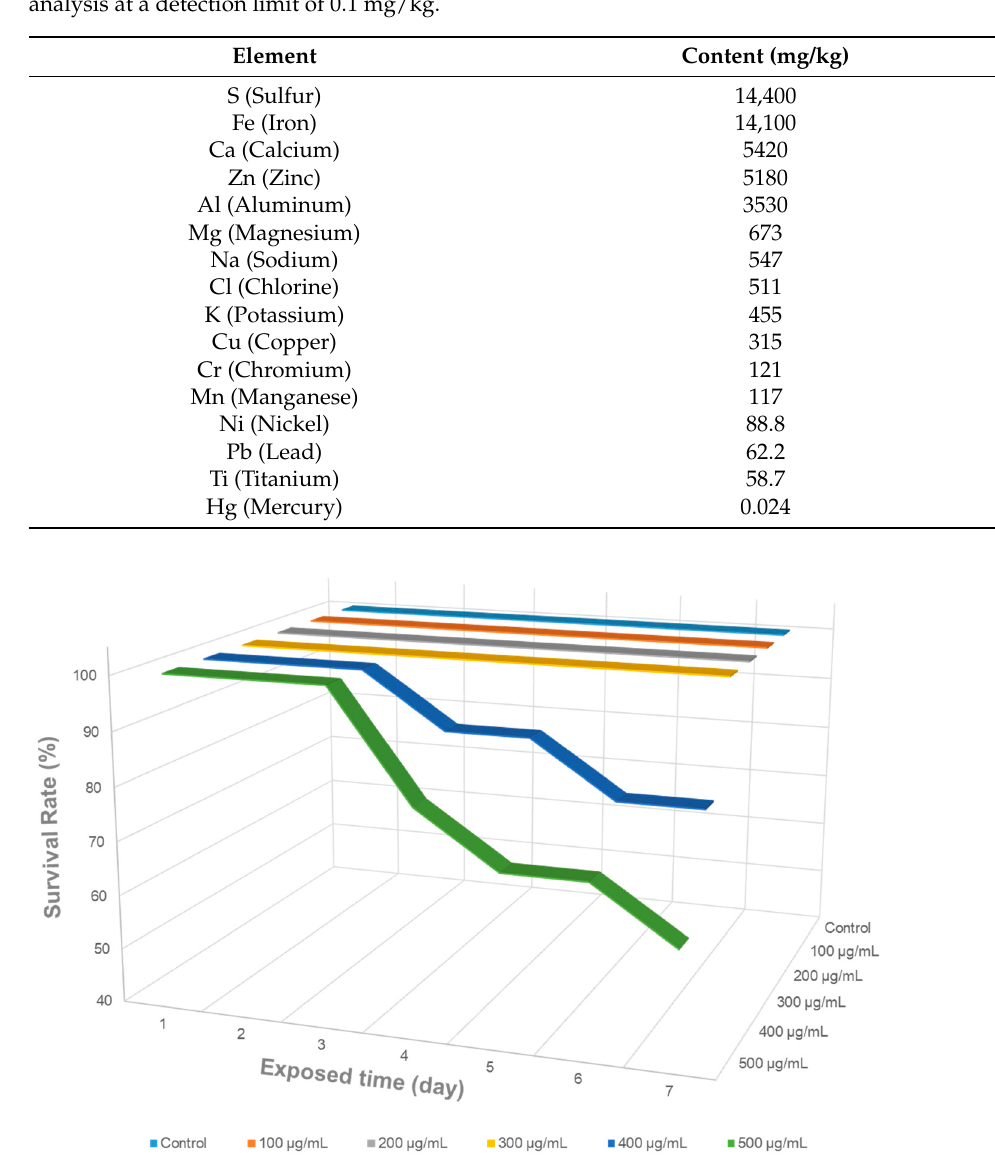
Figure 2. Survival rate (%) of control and zebrafish exposed to different concentrations of KDP20 (100, 200, 300, 400, and 500 µg/mL) for 1 to 7 days. The survival rates were recorded and observed daily ( n = 10).